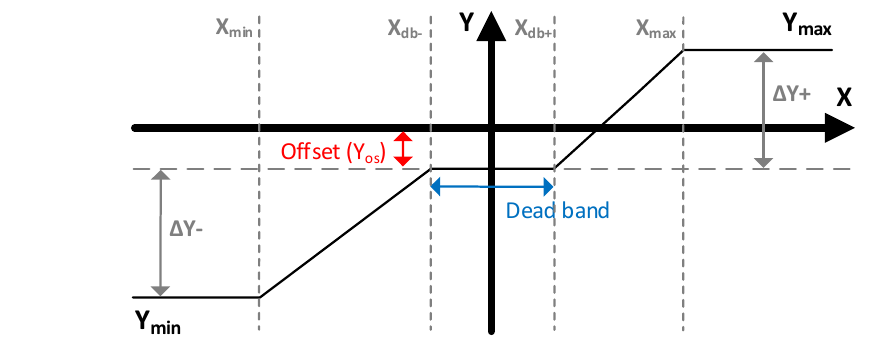
Figure 12. General curve followed by droop controllers.